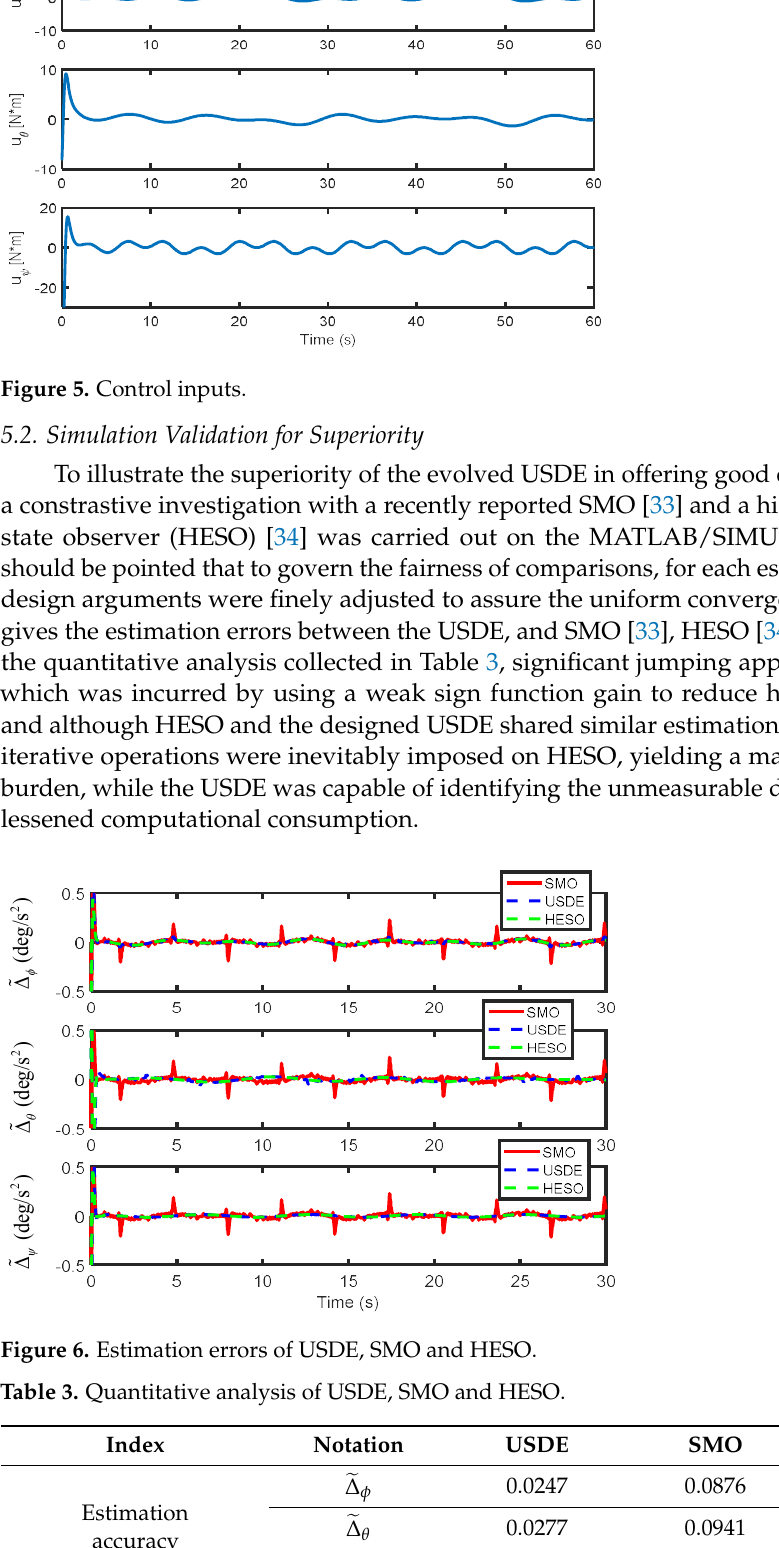
Figure 5. Control inputs.